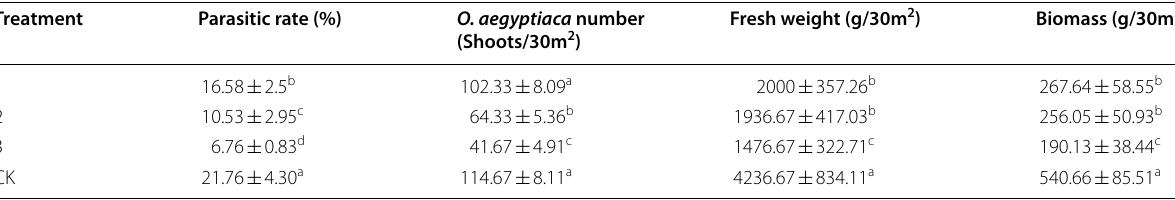
Table 2 Parasitic rate, O. aegyptiaca number, fresh weight and biomass of different treatment in the field Treatment